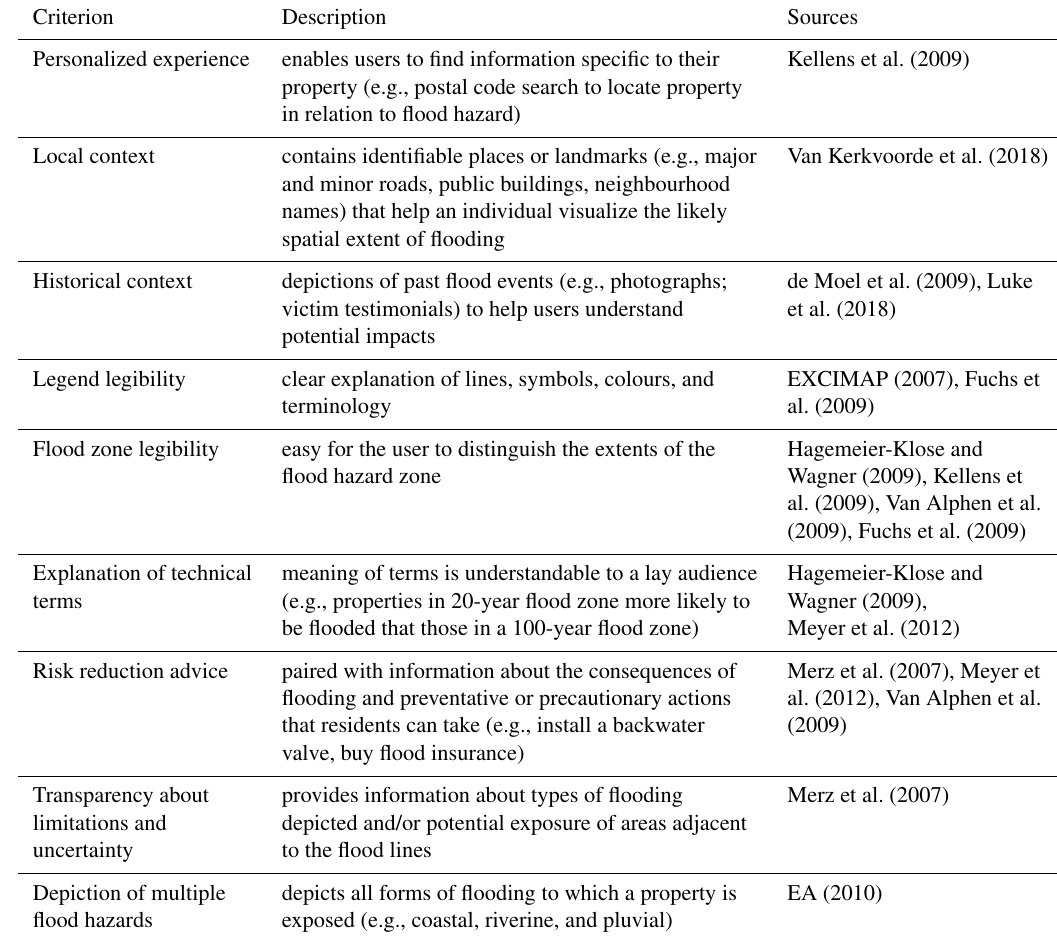
Table 2. Map assessment criteria, examples, and scholarly